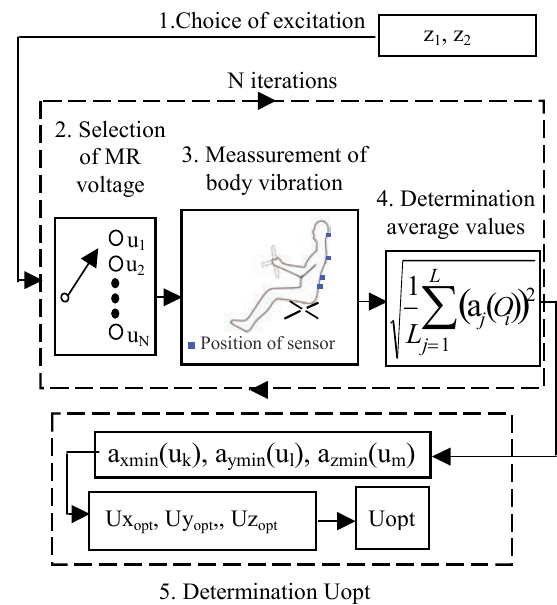
Fig. 2. The algorithm of MR suspension Figure 2. The algorithm of MR suspension adaptation for individual adaptation for individual driver.